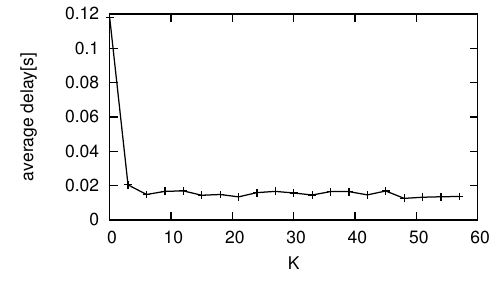
Figure 3: the evaluation of the average delay for values of K